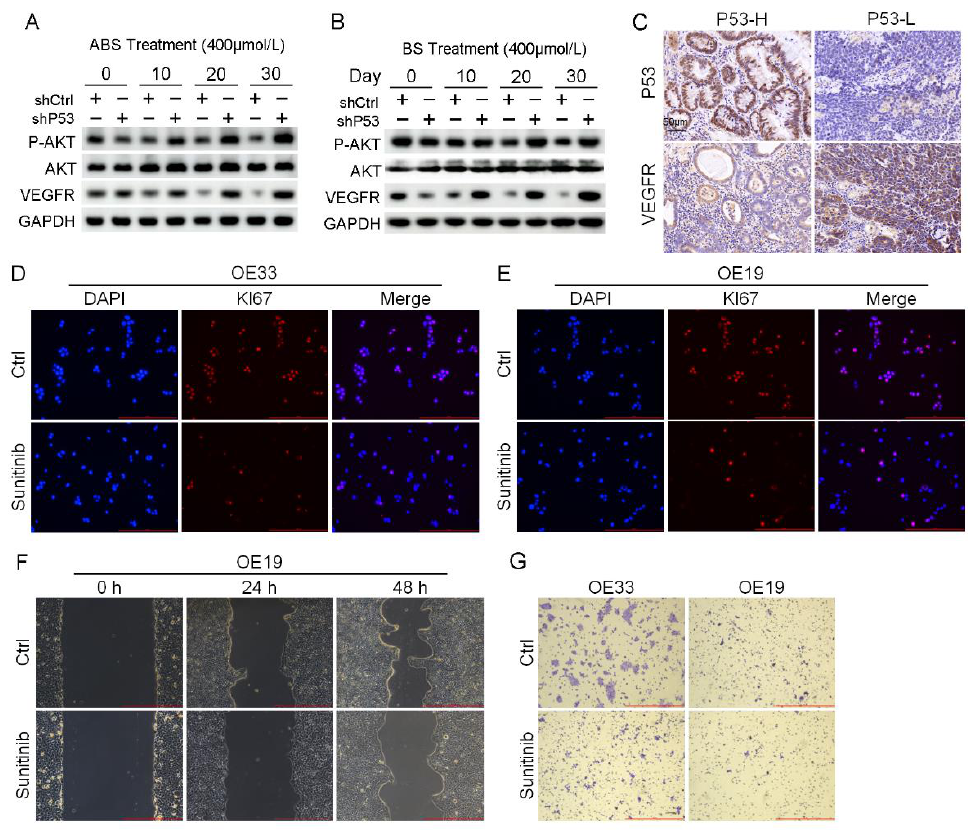
Figure 6. Venerability of VEGFR signaling pathway in P53 deficient EAC cells. ( A ) The protein expression level of AKT , VEGFR and phosphorylation of AKT . ( B ) The protein expression level of AKT , VEGFR and phosphorylation of AKT . ( C ) Representative images of P53 and VEGFR IHC staining. ( D , E ) Representative images of OE33 cells ( D ) and OE19 cells ( E ) by Ki67 immunofluorescence after treatment with 2 µ mol/L Sunitinib. ( F ) OE33 cell migration capacity after treatment with 2 µ mol/L Sunitinib. ( G ) Transwell assay for OE33 and OE19 cell lines after treatment with 2 µ mol/L Sunitinib. +: Treated accordingly; − : Not treated accordingly. Data were statistically analyzed using the student t